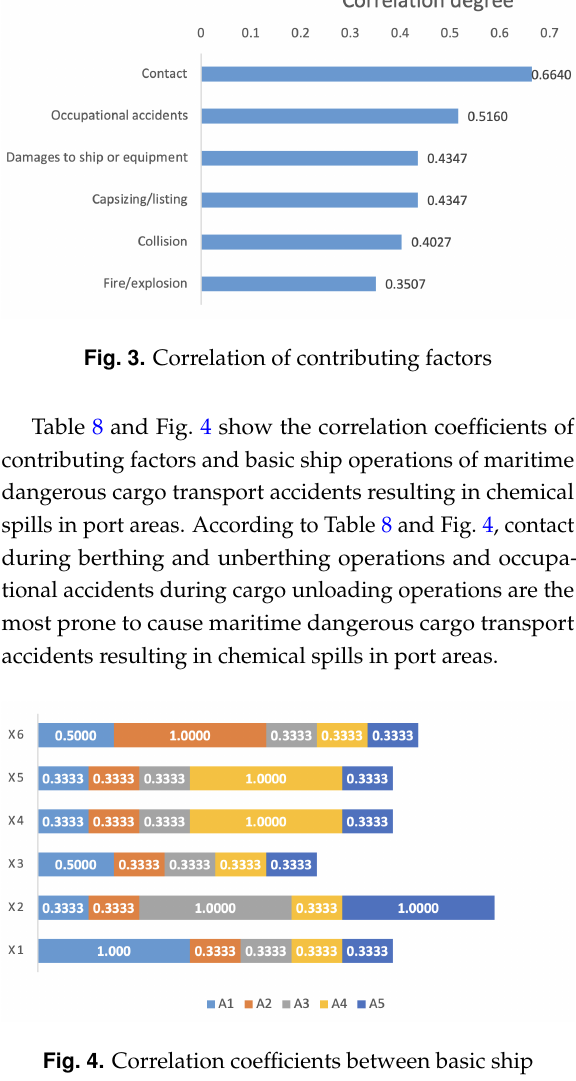
Fig. 4. Correlation coefficients between basic